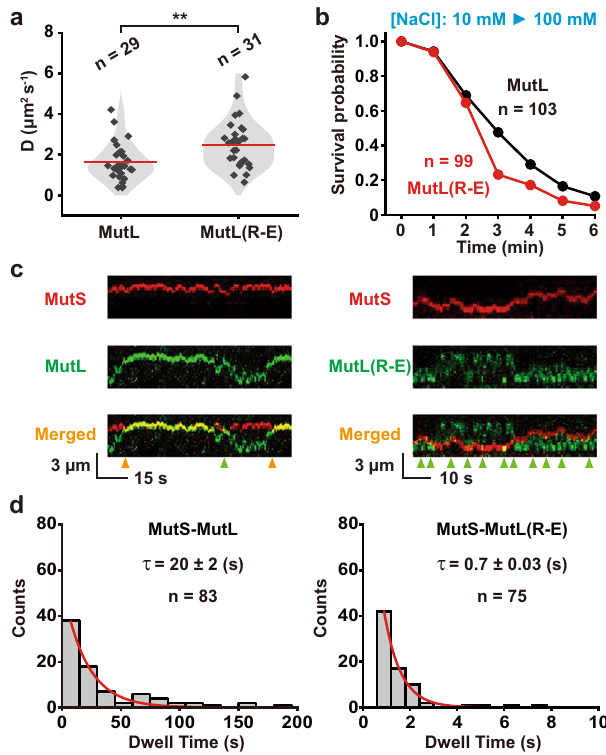
Fig. 4 | The biophysical properties of fast-diffusing wild-type MutL and MutL(R-E) sliding clamps on mismatched DNA. a Violin plots of the diffusion coef fi cient ( D ) for wild-type MutL and MutL(R-E) sliding clamps examined after buffer exchange to physiological ionic strength (~120mM, n =number of events examined).Statisticalsigni fi canceand p value( p =0.003)weredeterminedbytwo- sided t -testforthecomparisonbetweentwogroups. ‘ ** ’ represents0.001< p <0.01. b Survival probability of wild-type MutL or MutL(R-E) sliding clamps determined afterbufferexchangetophysiologicalionicstrength(~120mM, n =totalnumberof molecules). c Representative kymographs showing association-dissociation of MutS and MutL sliding clamps to form MutS-MutL complex (left). Note only tran- sient interactions between MutS and MutL(R-E) sliding clamps (right). Orange arrowheads indicate the MutS-MutL collisions with stable interactions. Green arrowheads indicate the MutS-MutL collisions with transient interactions. d The distribution of dwell times for MutS-MutL or MutS-MutL(R-E) complexes shown in c . Data were fi t to a single exponential decay to derive the average lifetime ( τ , mean±s.e.; n =number of events